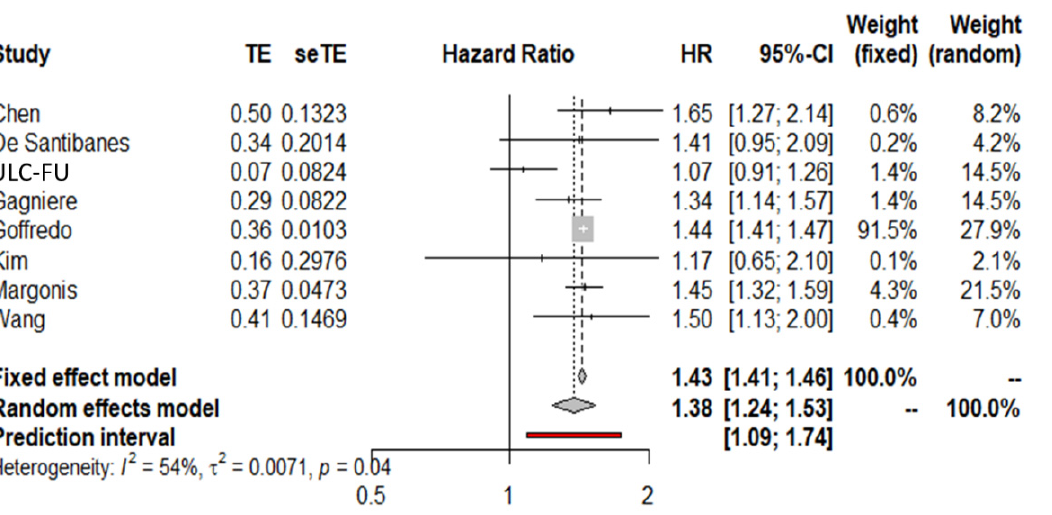
Figure 3. (A) Forest plot for right vs left (without rectum) in patients with KRAS-mutated tumors, (B) Forest plot for right vs left (without rectum) in patients with KRAS wild-type tumors; reference: right side.